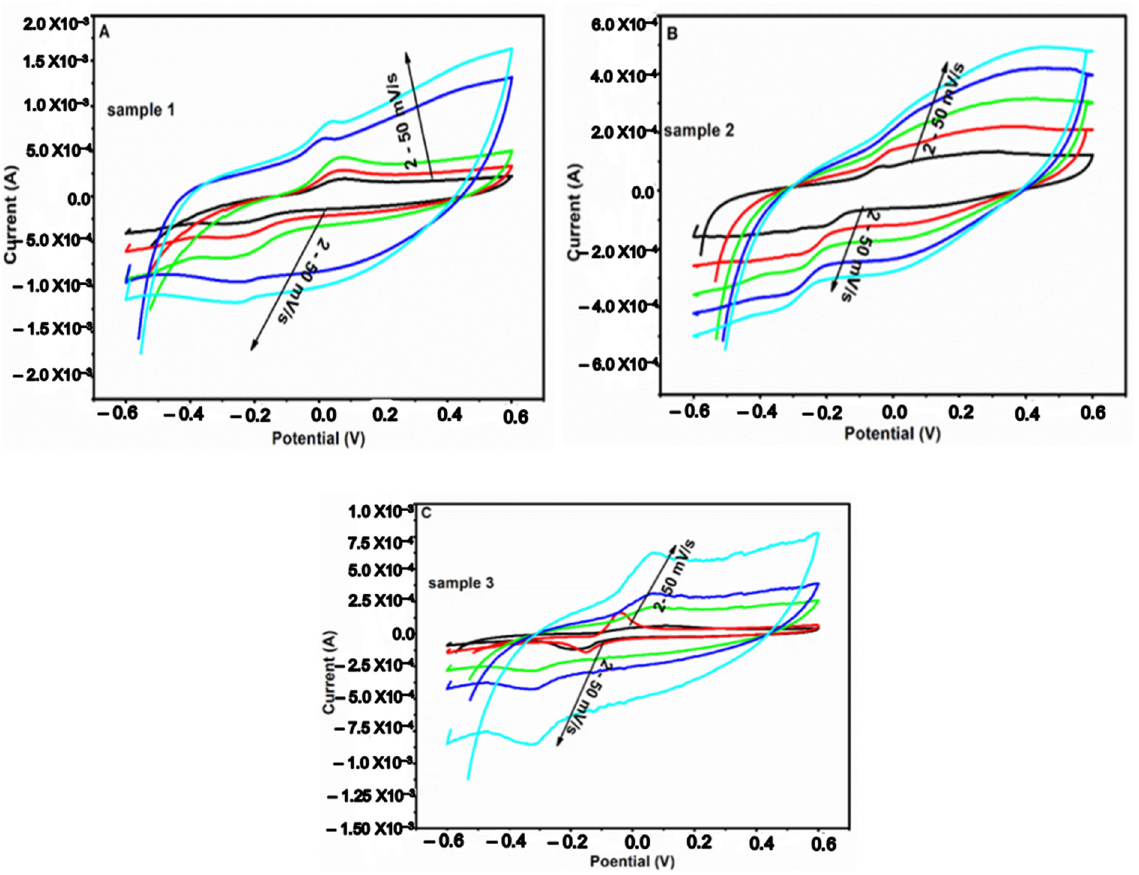
Figure 8. Cyclic voltammetric at different scan rates (2–50 mV/s). ( A ): GCE/ CuO-TiO 2 30/70 (S1) ( B ): GCE/ CuO-TiO 2 50/50 (S2) and ( C ) GCE/ CuO-TiO 2 70/30 (S3) in 0.5 M H 2 SO 4 as an electrolyte.